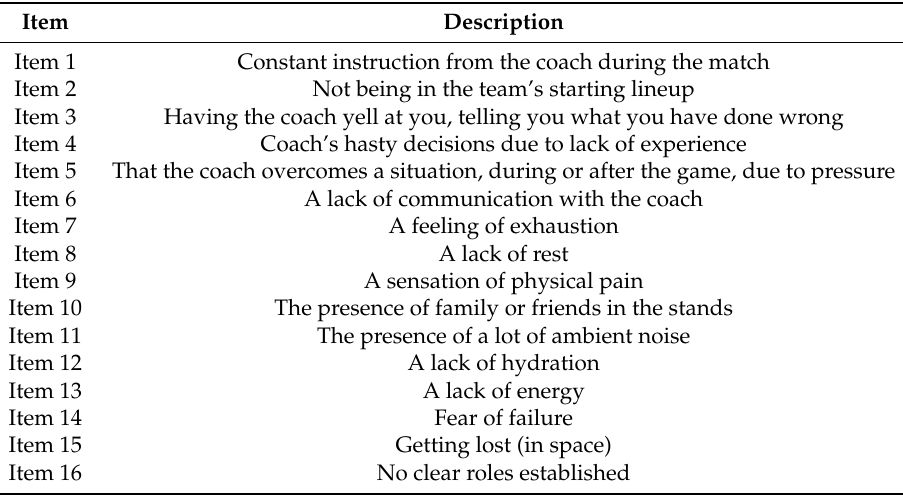
Table 1. Items of the first version of the